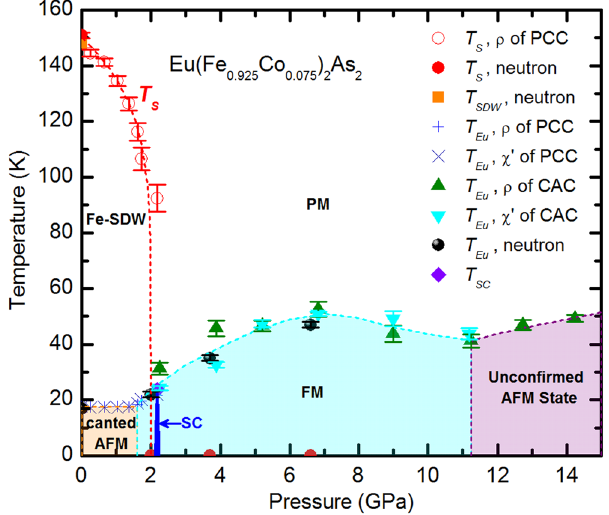
Figure 7. Pressure-temperature phase diagram of Eu(Fe 0.925 Co 0.075 ) 2 As 2 determined from the resistivity, ac magnetic susceptibility, and neutron diffraction